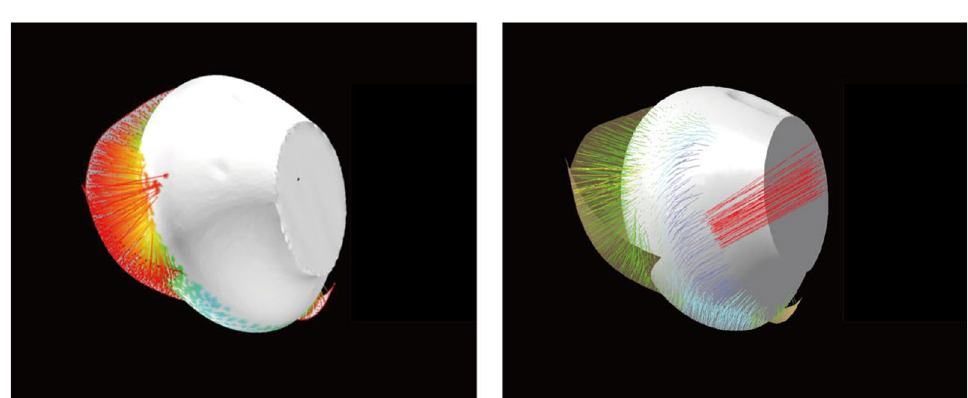
Figure 10. The visual effect between concha and earphone by deviation analysis tool of CATIA (right) and deviation analysis algorithm